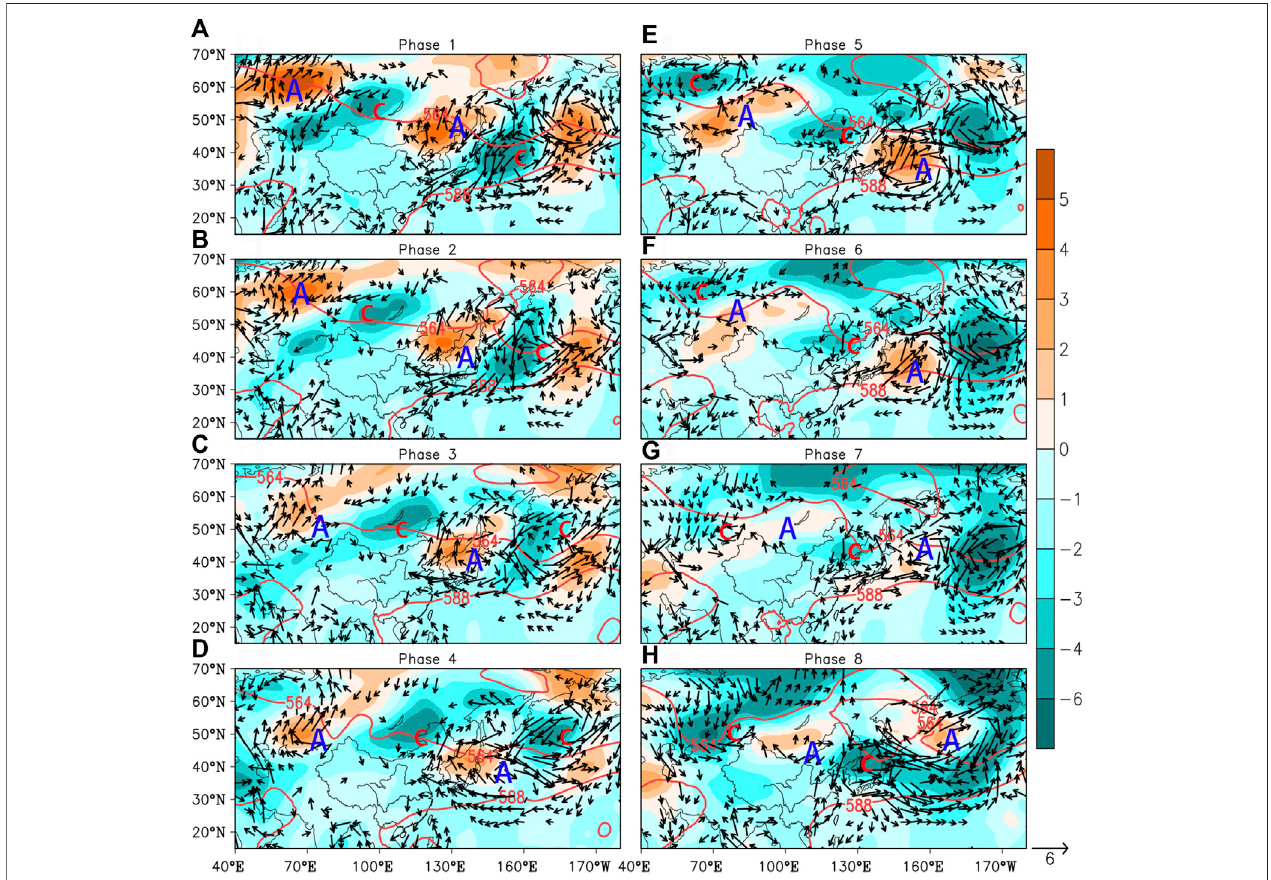
FIGURE 9 | Composite 8 – 16-day Lanczos fi ltered 500-hPa height (shaded, unit: dagpm) and 925-hPa winds (only fi lter value exceeding 1 m s -1 is shown by vectors).MarksofC/A denotescyclonic/anticyclonic fi ltered circulation)correspondingtoeight evolutionphasesofQWBO rainfallinsecond andthirdrainfallprocesses. Redlinesdenote564-and588-dagpmcontoursatun fi ltered500-hPaGHs. A – H correspondtotheeightphasesofthecompositeevolutionofQWBOcomponentofthe the second to third rainfall